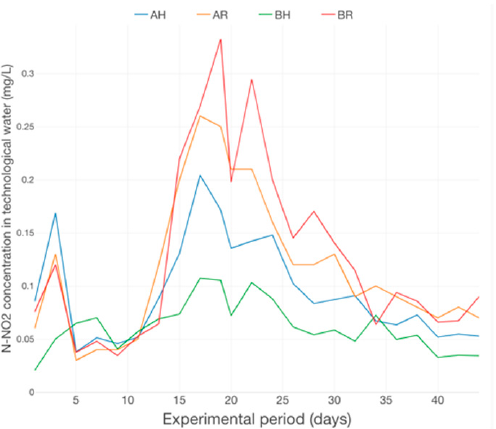
Figure 18. The dynamics of N-NO 2 concentration in technological water for each of the experimental variants.